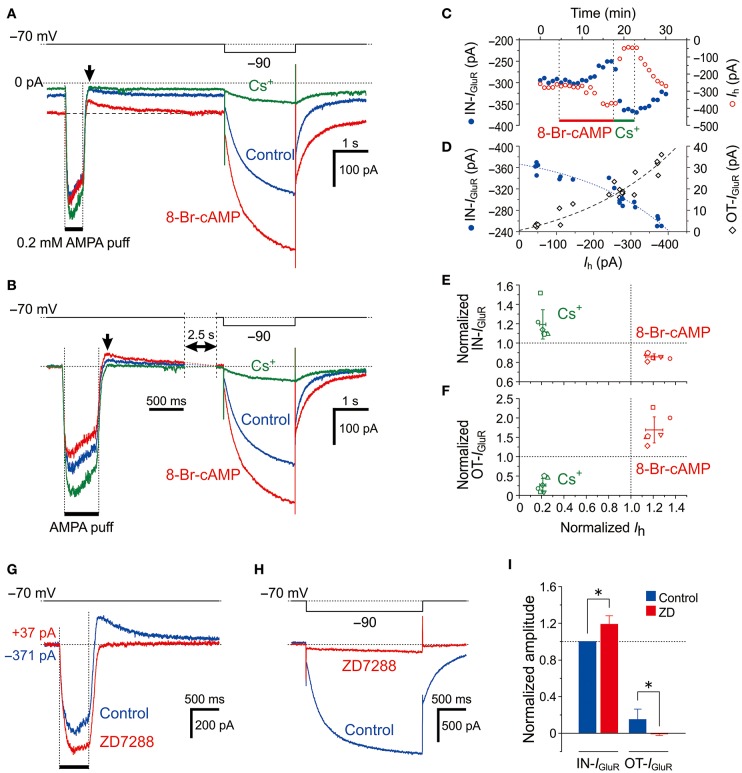
Effects of Ih activation by 8-Br-cAMP on IGluR. (A,B) Current responses to a 500-ms puff application of 0.2 mM AMPA and a hyperpolarizing pulse (−20 mV, 500 ms) recorded before (blue traces), during the application of 8-Br-cAMP (red traces), and during the application of Cs+ (green traces) under the voltage-clamp condition at −70 mV (A). The baseline current levels were aligned (B). The arrows indicate the outward components of IGluR (OT-IGluR). (C) Plot of the amplitudes of the inward component of IGluR (IN-IGluR; blue filled circles) and the Ih (red open circles) against time during applications of 8-Br-cAMP and Cs+. Note the reciprocal changes in the amplitudes of IN-IGluR and Ih. (D) Plot of the amplitudes of IN-IGluR (blue filled circles) and OT-IGluR (black open diamonds) against those of Ih obtained before and during 8-Br-cAMP and Cs+ applications. Note the negative correlation between the amplitudes of Ih and the IN-IGluR and the positive correlation between the amplitudes of Ih and the OT-IGluR. (E,F) Relationship between the normalized amplitudes (mean ± SD) of the IN-IGluR (E) and OT-IGluR (F) and that of Ih observed during 8-Br-cAMP (red symbols) and Cs+ (green symbols) applications in six MTN neurons (n = 6). A set of four (red and green, E,F) symbols with the same shape represent data obtained from a single neuron. 8-Br-cAMP: Ih, 1.21 ± 0.08 (*P < 0.002); IN-IGluR, 0.86 ± 0.03 (*P < 0.001); OT-IGluR, 1.69 ± 0.33 (*P < 0.006). Cs+: Ih, 0.21 ± 0.03 (*P < 0.001); IN-IGluR, 1.19 ± 0.15 (*P < 0.04); OT-IGluR, 0.26 ± 0.17 (*P < 0.001). (G,H) Current responses to a 500-ms puff application of 0.2 mM AMPA (G) and a negative voltage pulse (−20 mV, 2 s) (H) recorded before (blue traces) and during the application of ZD7288 (red traces). The baseline current levels were aligned. (I) Mean (± SD) normalized amplitudes of the IN-IGluR and OT-IGluR before (blue columns) and during the application of ZD7288 (red columns) (n = 6). *: P < 0.05.